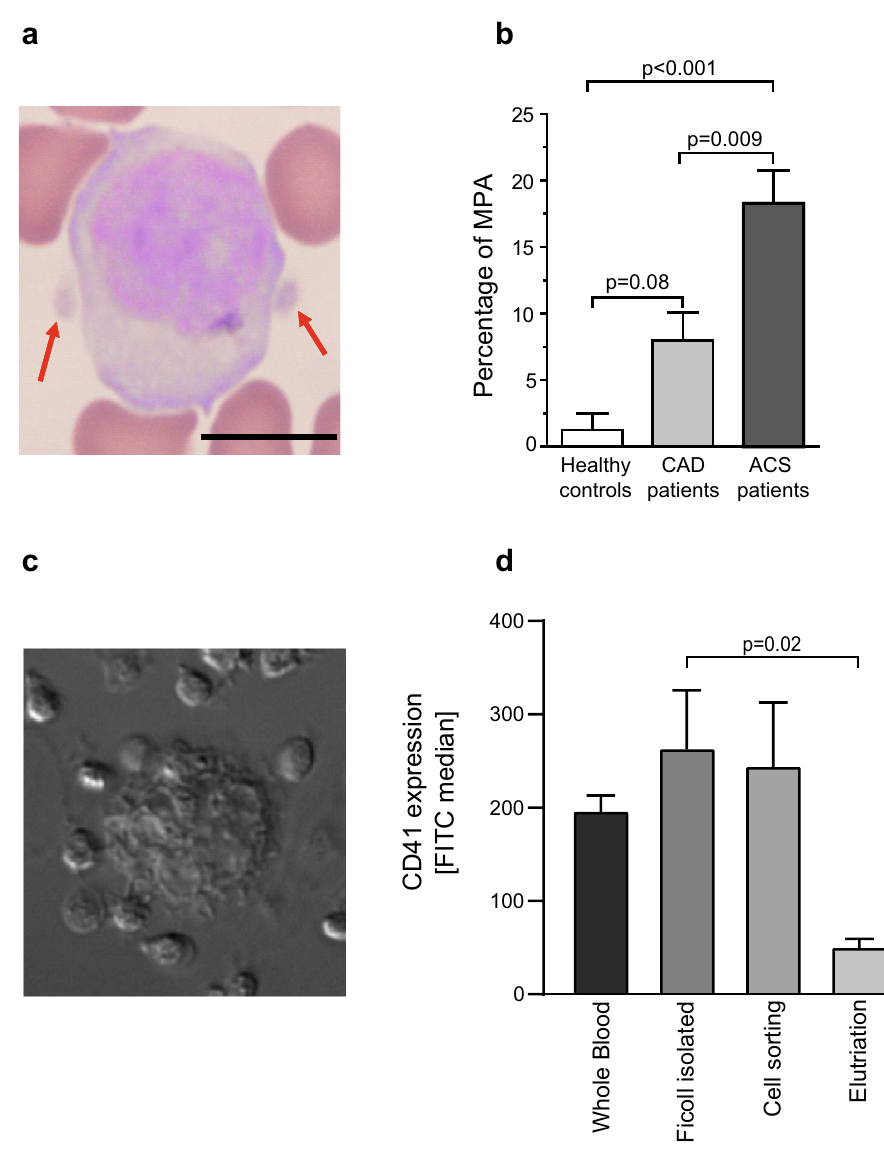
Figure 2. Presence of monocyte platelet aggregates in circulating blood of healthy volunteers and patients with CAD and ACS using different monocyte isolation methods. To determine whether MPA are present in all monocytes isolated from whole blood, levels of MPA were assessed using different methods as described in the “Methods” section. ( a ) Platelets adherent to monocytes were found in small numbers in the blood smears of healthy subjects. The light microscopic image depicts a monocyte with two adhering platelets indicated by arrows. Scale bar = 10 µm. ( b ) Quantification of MPA in percentage of all monocytes in blood smears demonstrated increasing percentages of monocytes with adherent platelets in healthy volunteers, CAD and patients with acute coronary syndrome. n = 5 per group. ( c ) Microscopic image of a representative monocyte isolated by Ficoll density gradient centrifugation at 1000× magnification using an inverted microscope. ( d ) MPA were found in healthy subjects after isolation of monocytes using different isolation methods. n ≥ 3, p -values were calculated using one-way